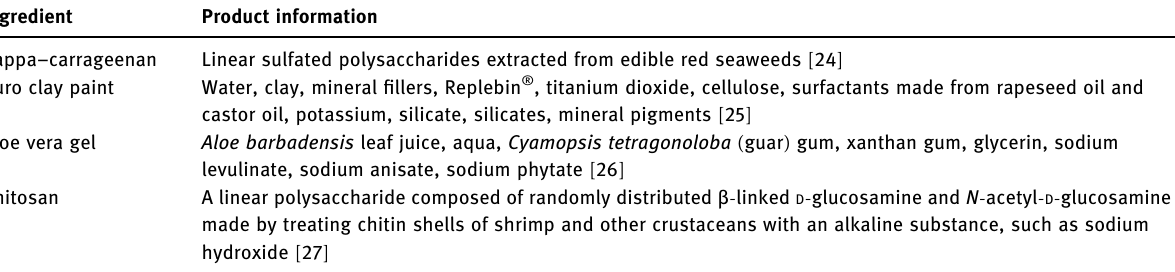
Table 1: List of primary bio – gel components and their composition Ingredient Product